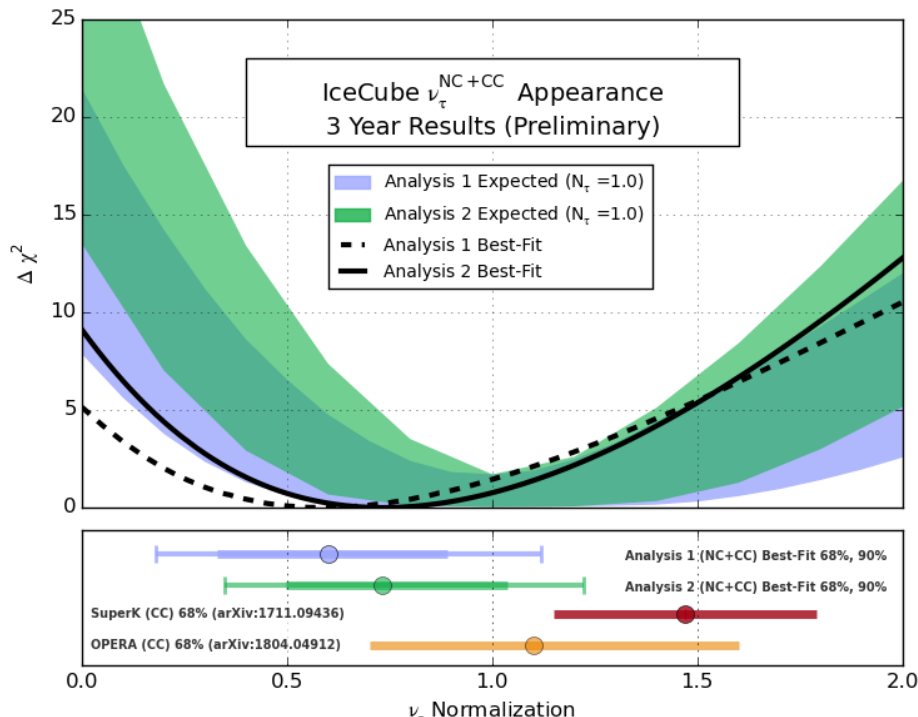
Figure 6: Tau normalisation results for two independent IceCube DeepCore analyses (Analysis 1 and Analysis 2) compared to the corresponding OPERA and SuperK re- sults. The Feldman-Cousins method was used in the estimation of the 68% and 90% confidence intervals in the bottom part of the plot. Plot source: [ 11 ] .